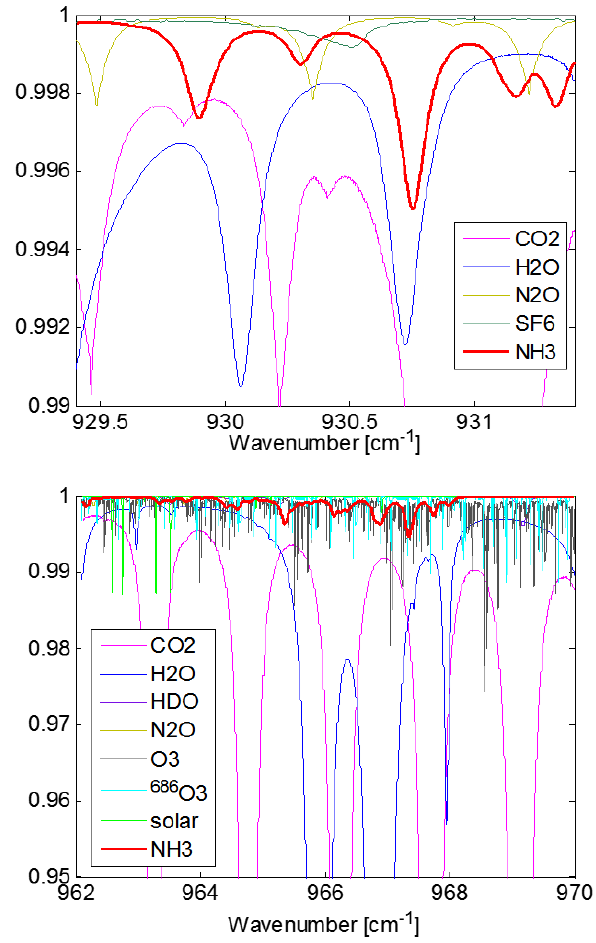
Figure 2. Example of a synthetic atmospheric spectrum for both spectral windows at Réunion Island, computed for 5 June 2011, and a total column of 1 . 07 × 10 15 molecules cm − 2 . The top panel shows the individual contributions of the main species in the first spectral window. The bottom panel shows the second spectral